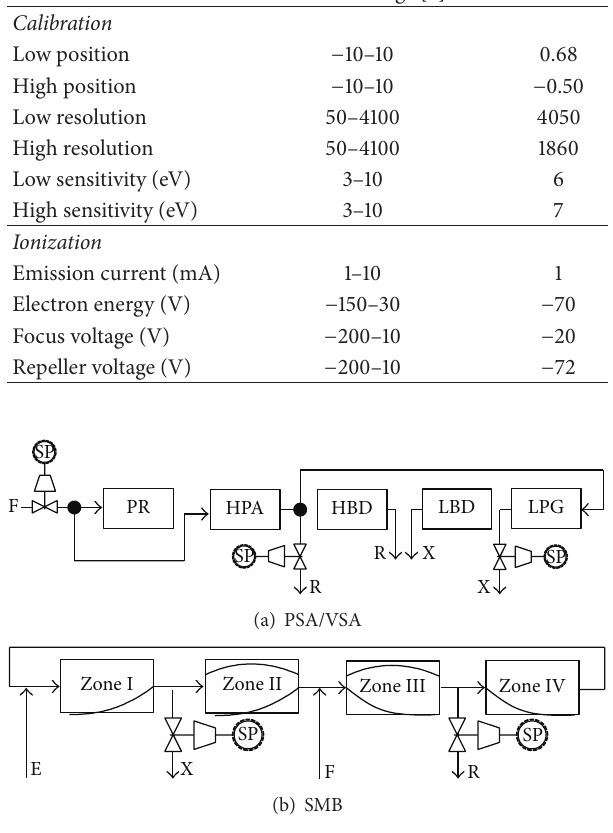
Figure 2: Schematics of adsorption based separation processes, namely, (a) PSA cycle implemented for the CO 2 /N 2 separation. For the sake of simplicity the scheme only shows the sequential steps of the cycle for one column: Pressurization (PR), High Pressure Adsorption (HPA), High Pressure Blowdown (HBD), Low Pressure Blowdown (LBD), and Low Pressure Purge (LPG). (b) Conventional SMB scheme, which is divided into four zones, one for adding the gaseous desorbent or carrier gas (E), one for withdrawing the slow-migrating adsorbates (X), one for continuous feeding (F), and the last one for withdrawing the fast-migrating adsorbates (R). The positions of the input and output streams are shifted downstream by one column, at fixed intervals, in the direction of gas flow. SP: sampling